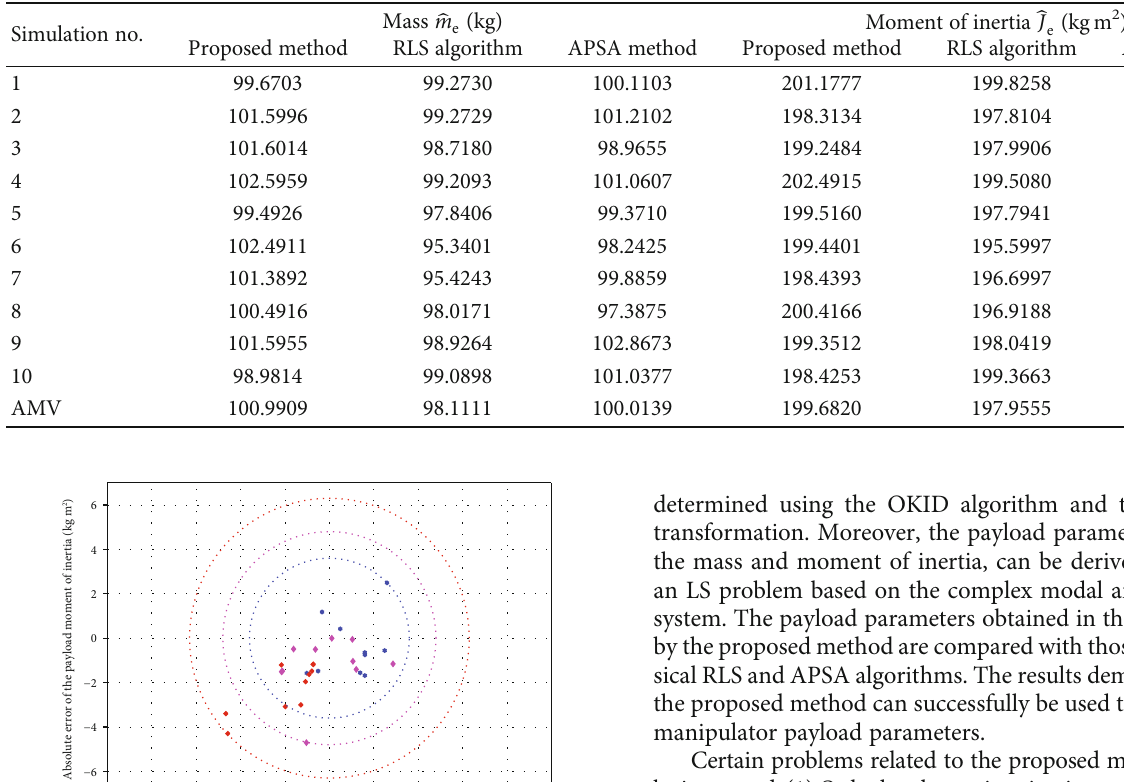
Table 4: Identi fi cation results of the payload parameters (10 simulations).